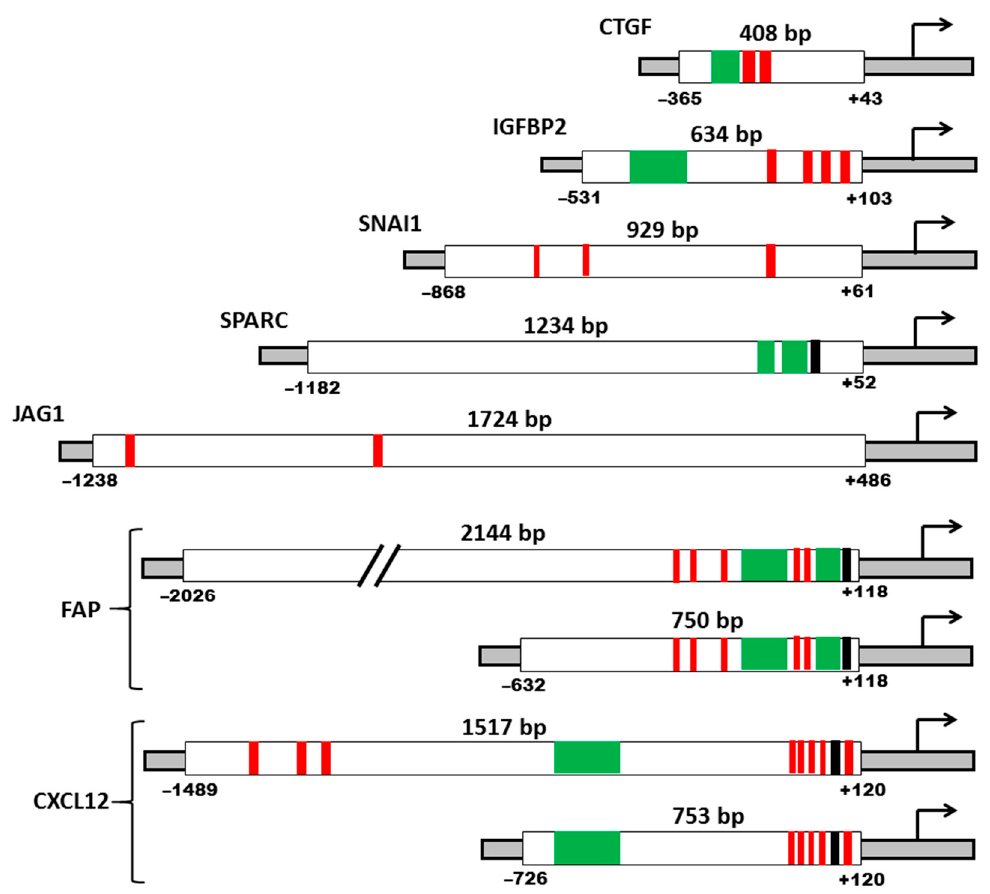
Figure 2. Schemes of promoter regions used in the work. Regions with several binding sites for transcription factors (TFs) are shown in green; deletion of such regions is critical for the activity of the promoter; sites of single binding TFs, important for the activity of the promoter, are marked in red; TATA-like regions are marked in black; the curved arrow indicates the translation initiation site.